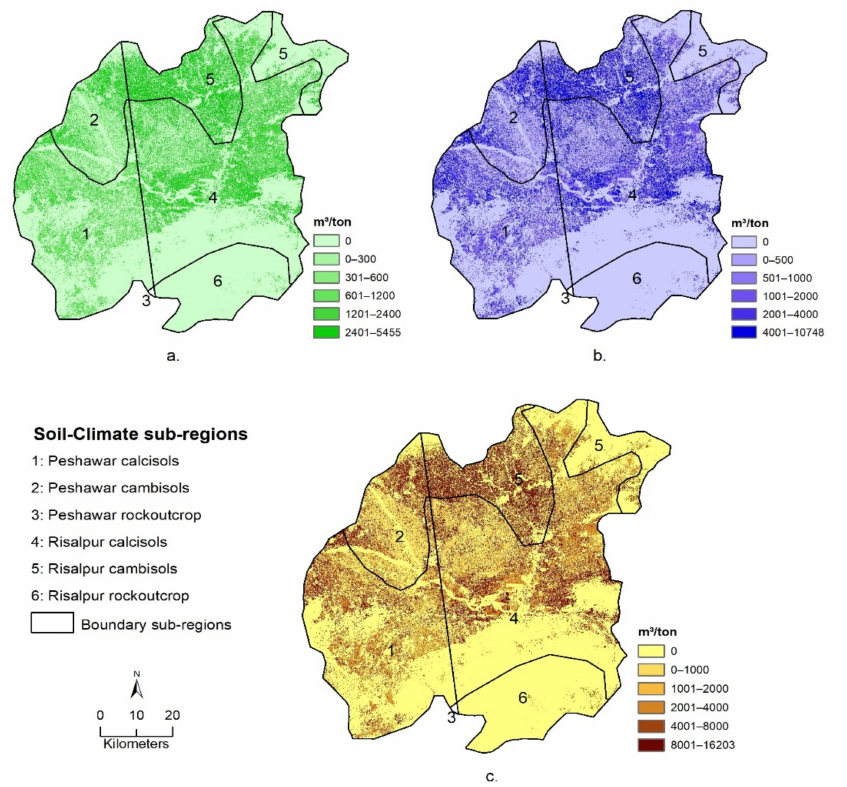
Figure 4. Spatial distribution of average annual green ( a ), blue ( b ), and total WF ( c ) of major crops in Peshawar Basin